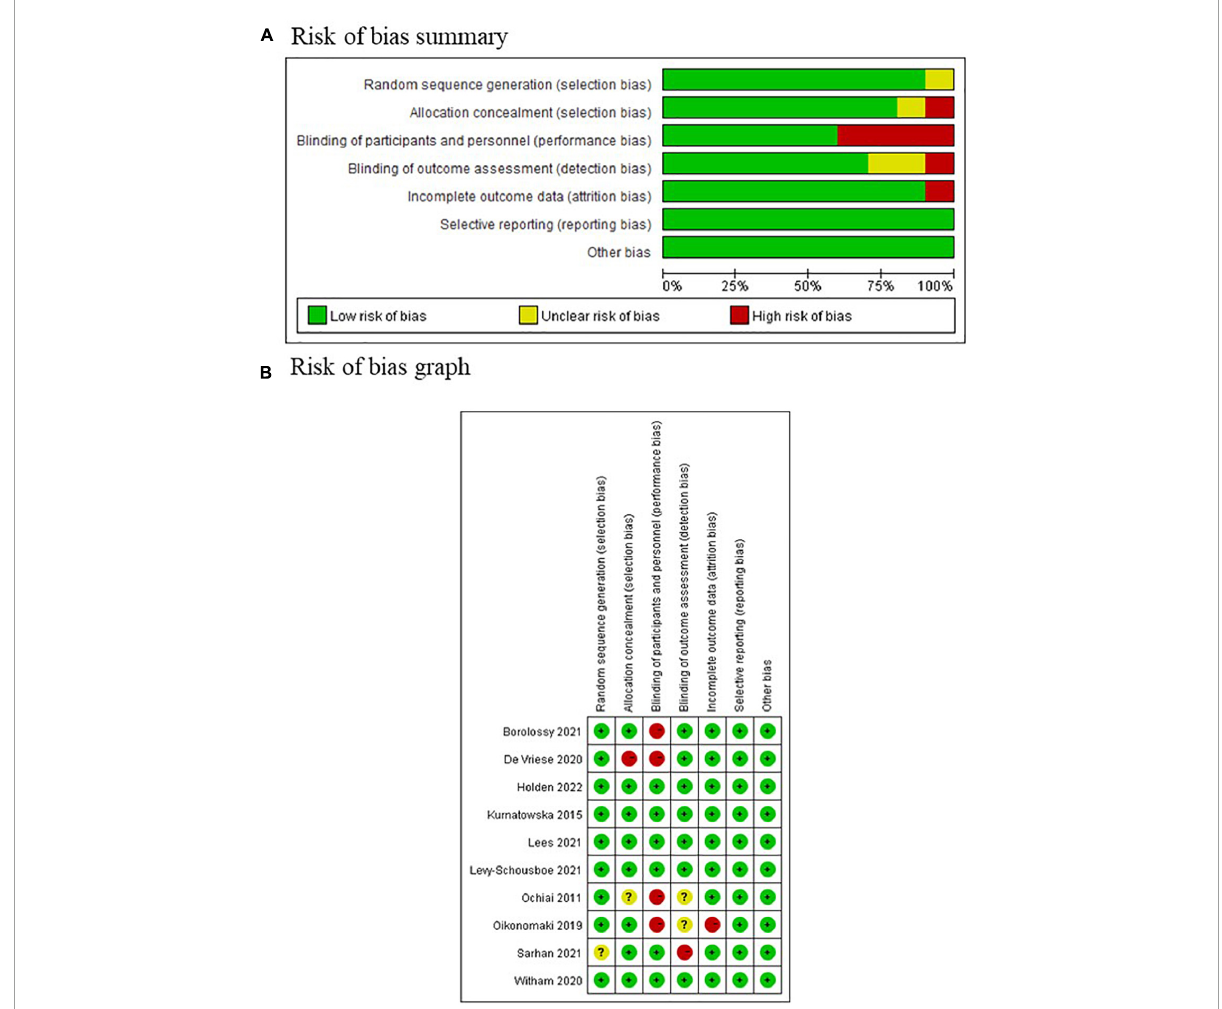
FIGURE7 Risk of bias assessment of included study according to the Cochrane systematic review guidelines. (A) Risk of bias summary graph; (B) traffic light graph of risk of